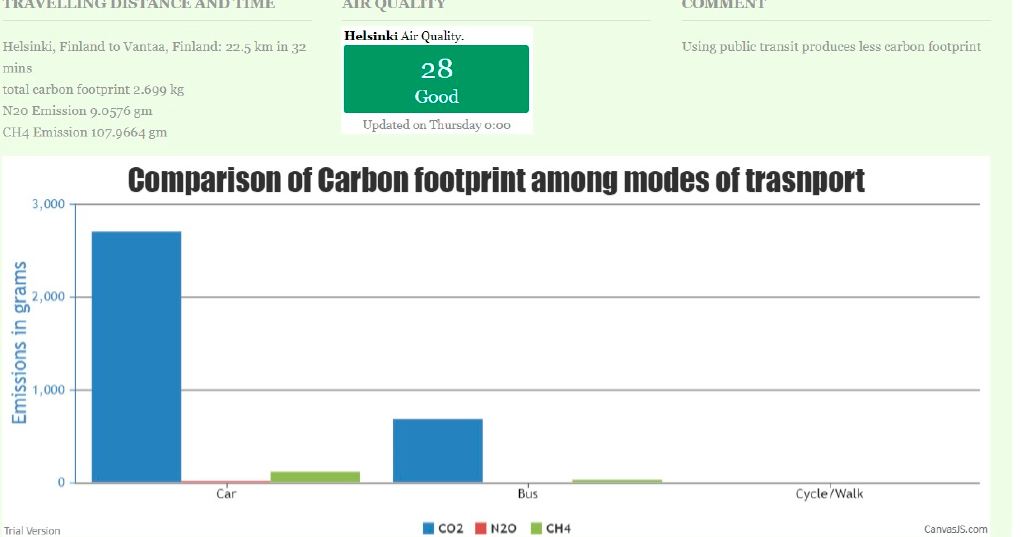
Figure 7. Sustainable smart city service in the form of the Green Commute application.